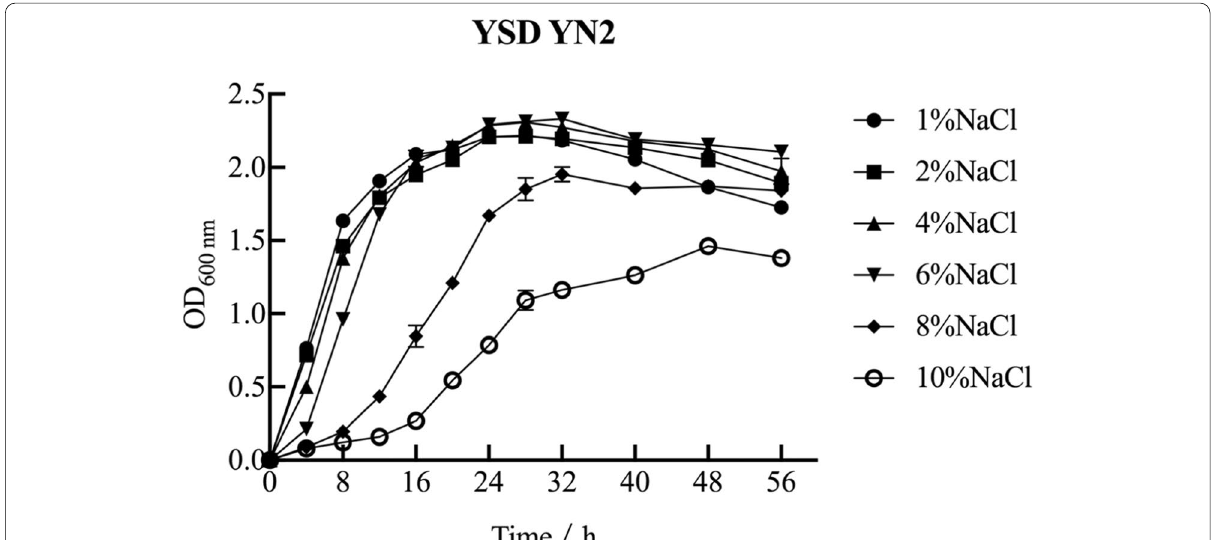
Fig. 2 Salinity tolerance growth curve of YSD YN2 under various saline conditions (1-10% NaCl). Error bars show the standard deviation of the mean values of three